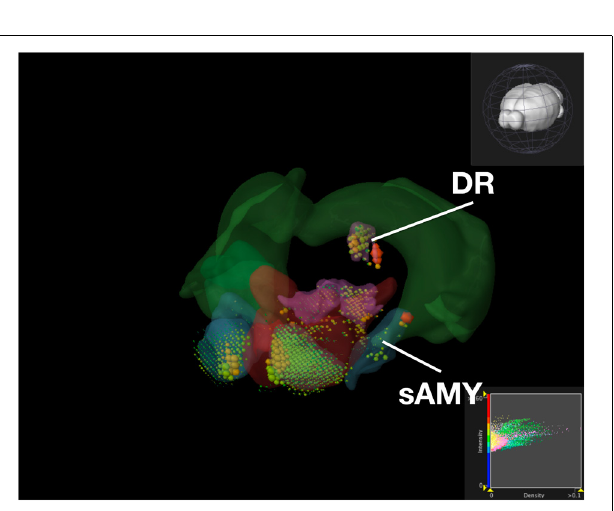
FIGURE 9 | Expression of Serotonin Receptor Genes in Brain Structures Associated with Reward Processing Using Brain Explorer 2. Colored spheres represent the amount of expression in a given brain structure, where blue–green is low, yellow is medium, and red is high. Spheres also represent each 200- µ m 3 voxel, with the size of the spheres directly proportional to the number of objects detected in each voxel.